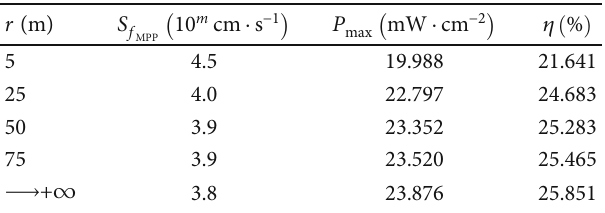
) and distance emission source-PV cell ð L f